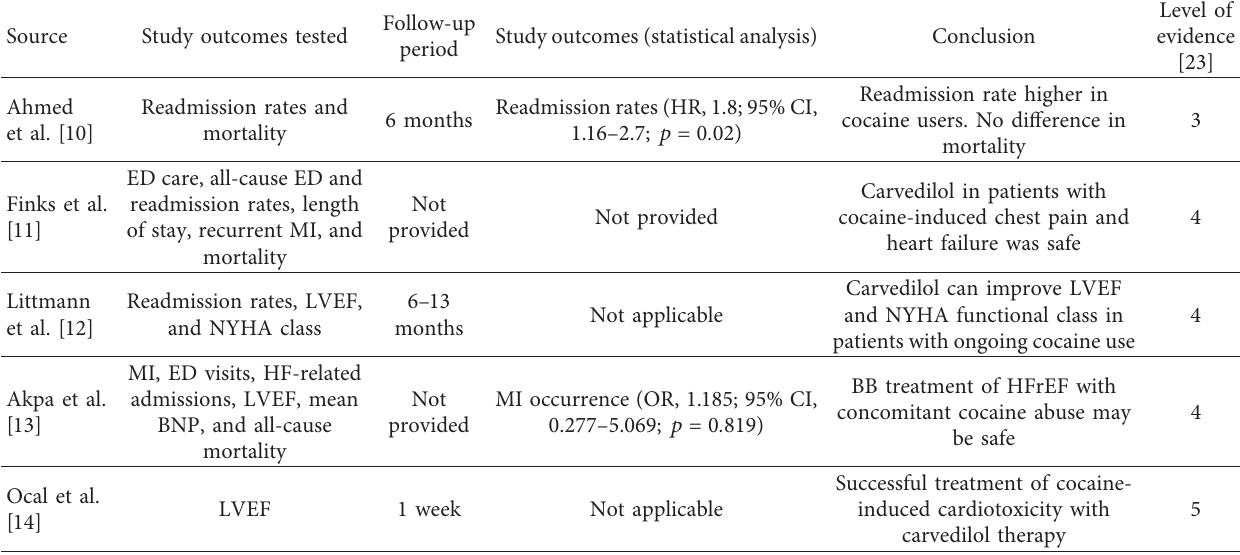
Table 2: Study outcomes and conclusions along with the level of evidence as per the Oxford Centre for Evidence-Based Medicine 2011 Levels of